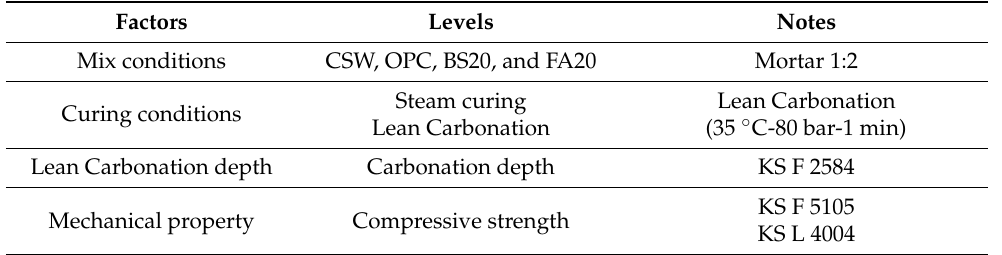
Table 9. Experimental factors and levels.